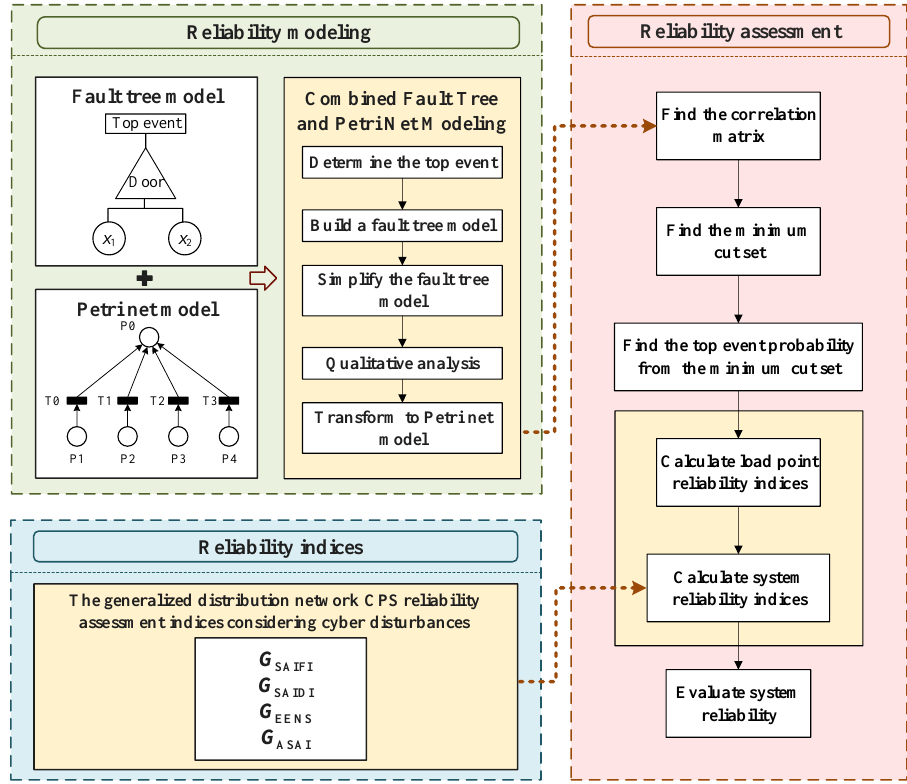
Figure 3. Block diagram of the proposed reliability assessment